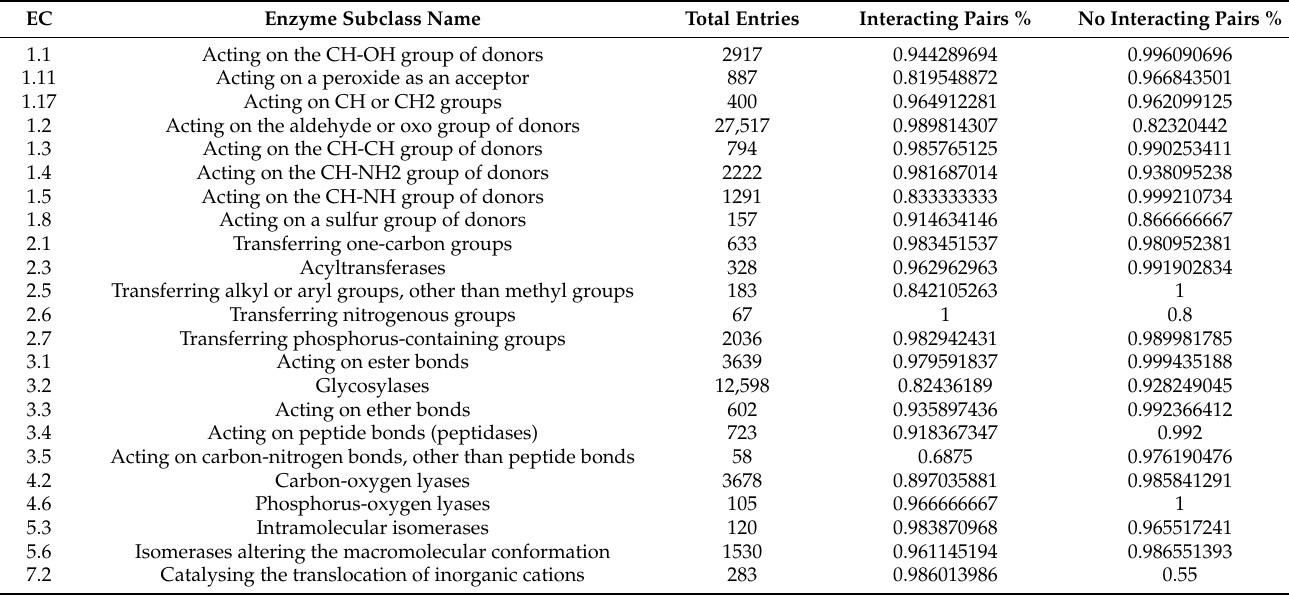
Table 3. Accuracy of the model for each